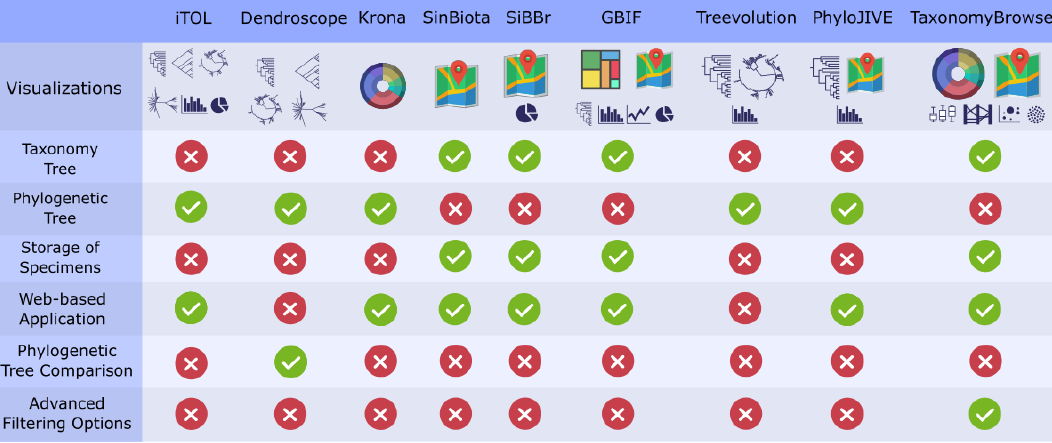
Figure 1. Comparison between iTOL, Dendroscope, Krona, SinBiota, SiBBr, GBIF, Treevolution and PhyloJIVE and TaxonomyBrowser (the solution presented in this paper) systems regarding their